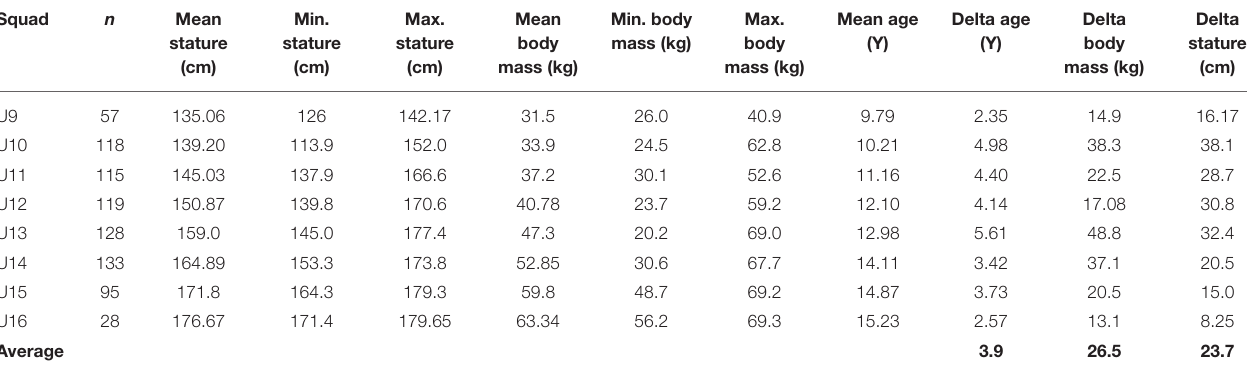
TABLE 2 | Number of players (n) by squad with mean, minimal and maximal anthropometric characteristics after reallocation. Squad